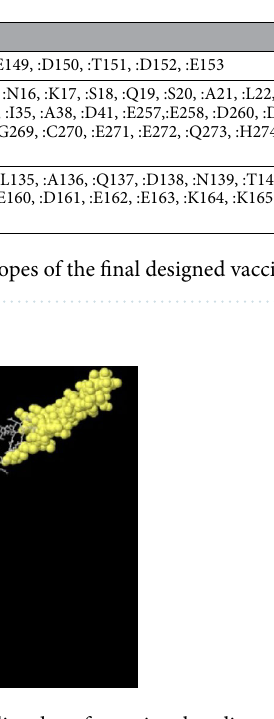
Figure 5. 3D demonstration of the predicted conformational or discontinuous B-cell epitopes in the final designed vaccine construct. A yellow surface indicates the conformational or discontinuous B cell epitopes, and the rest of the residues is illustrated in grey